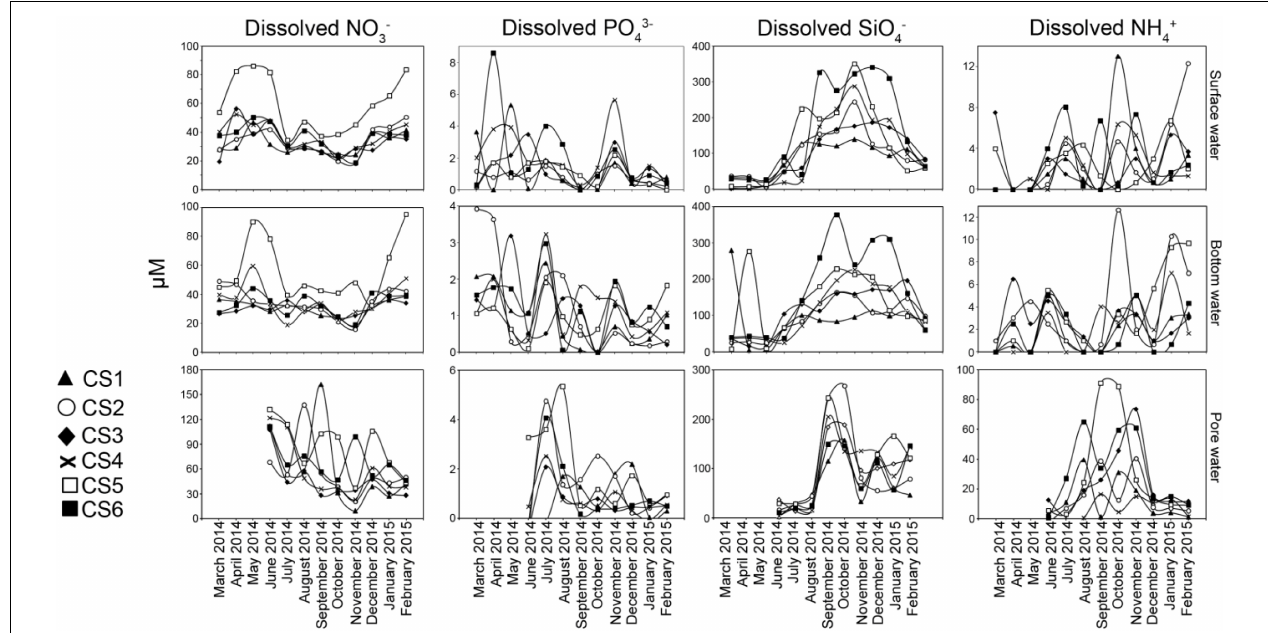
FIGURE 4 | Concentrations of dissolved nutrients estimated from surface water, bottom water, and pore water (sediment) measured from each sampling station of the lagoon during the sampling period representing March 2014 to February 2015. For pore water, measurements of the above parameters were undertaken from